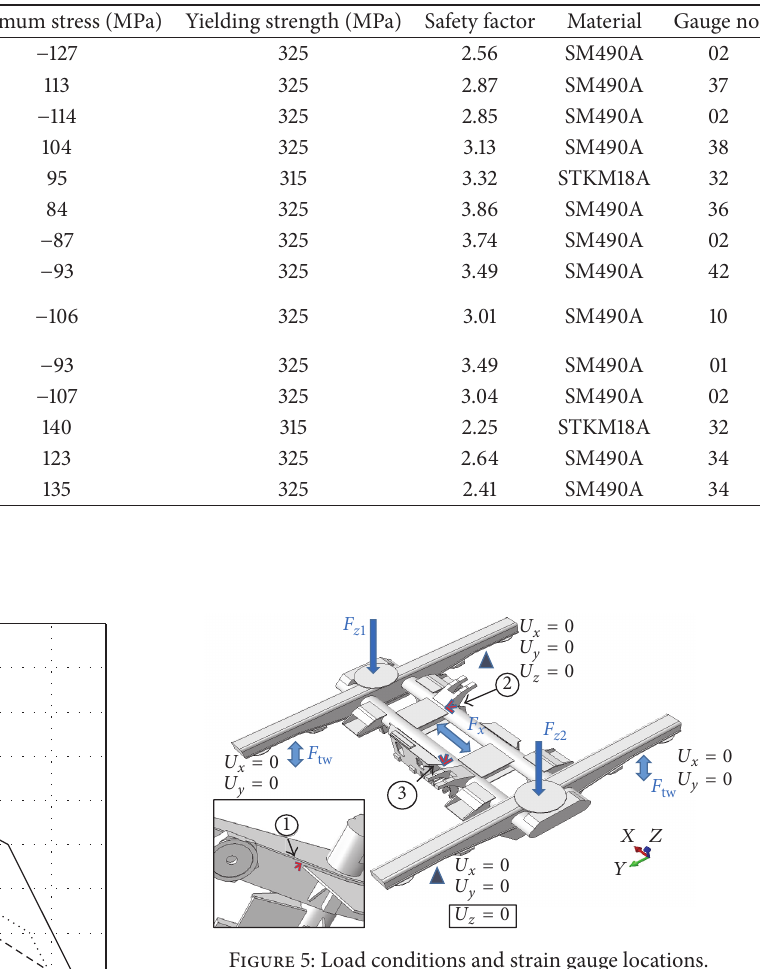
Table 3: Measured maximum stress for static test.